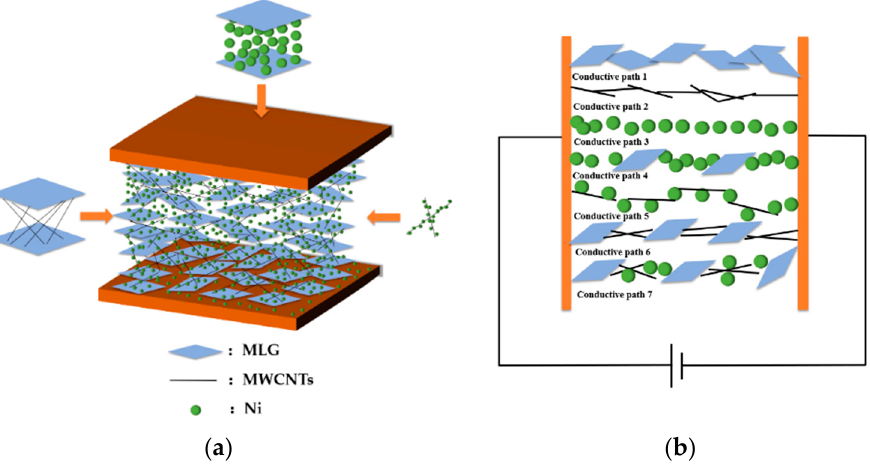
Figure 3. The microstructure of composites and conductive pathways. ( a ) The theoretical microstructure model of Ni/CNT/MLG composites and ( b ) the conductive paths during compression.